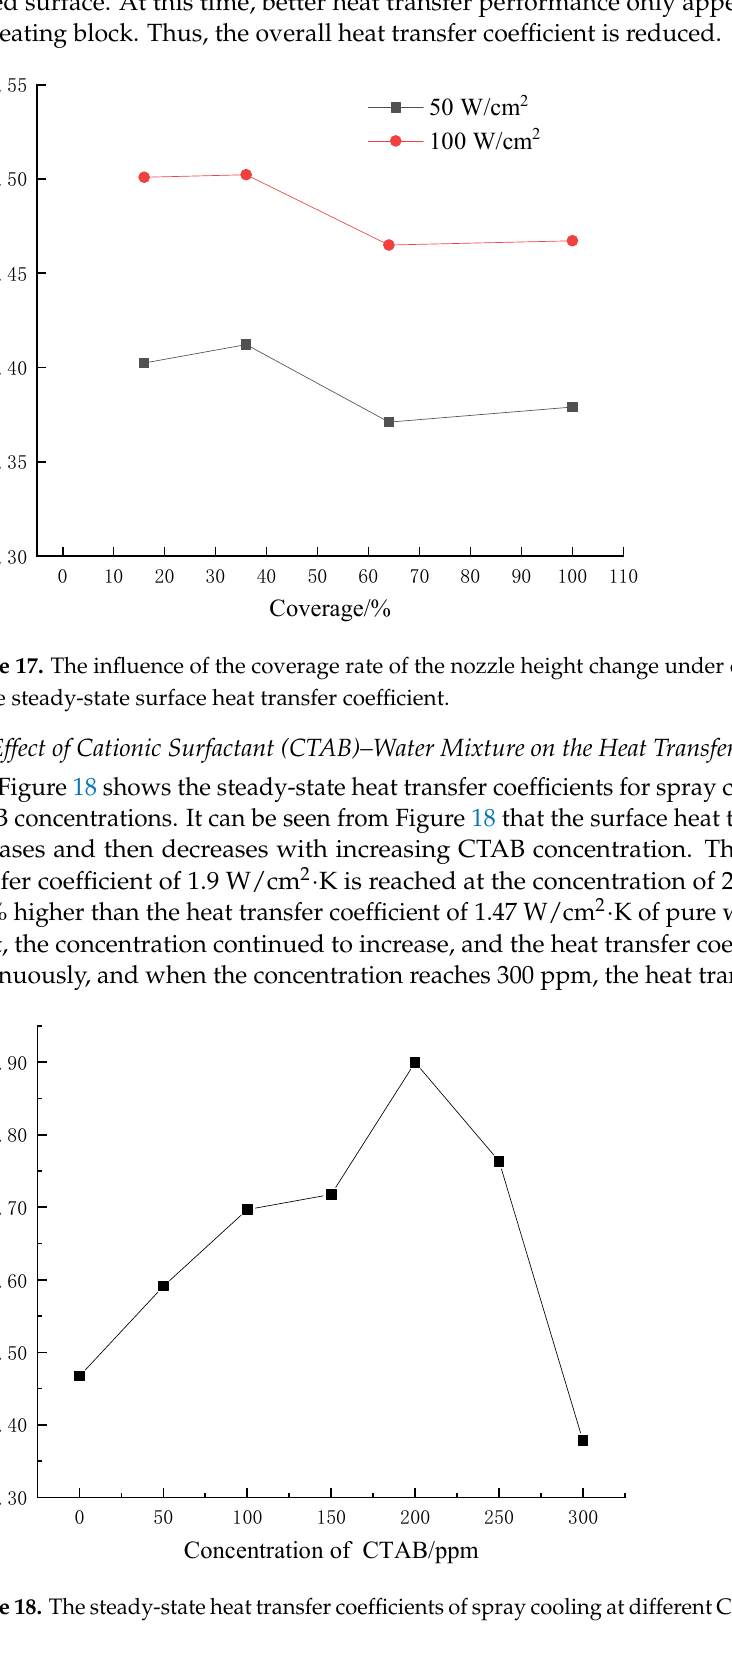
Figure 16. Visualization images of spray cone shape: ( a ) solid dense cone ， coverage16%; ( b ) solid cone above the heated surface has been parabolic, with fewer droplets in the center of the dense cone and hollow parabolic cone. heated surface. At this time, better heat transfer performance only appears at the edge of